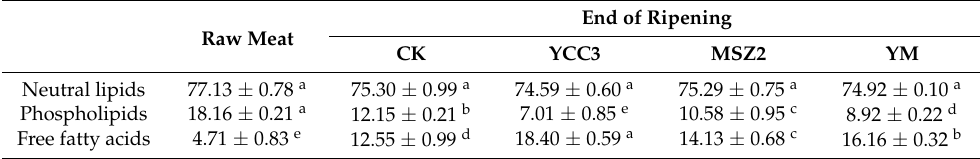
Table 1. Lipid composition in fermented sausage (g/100